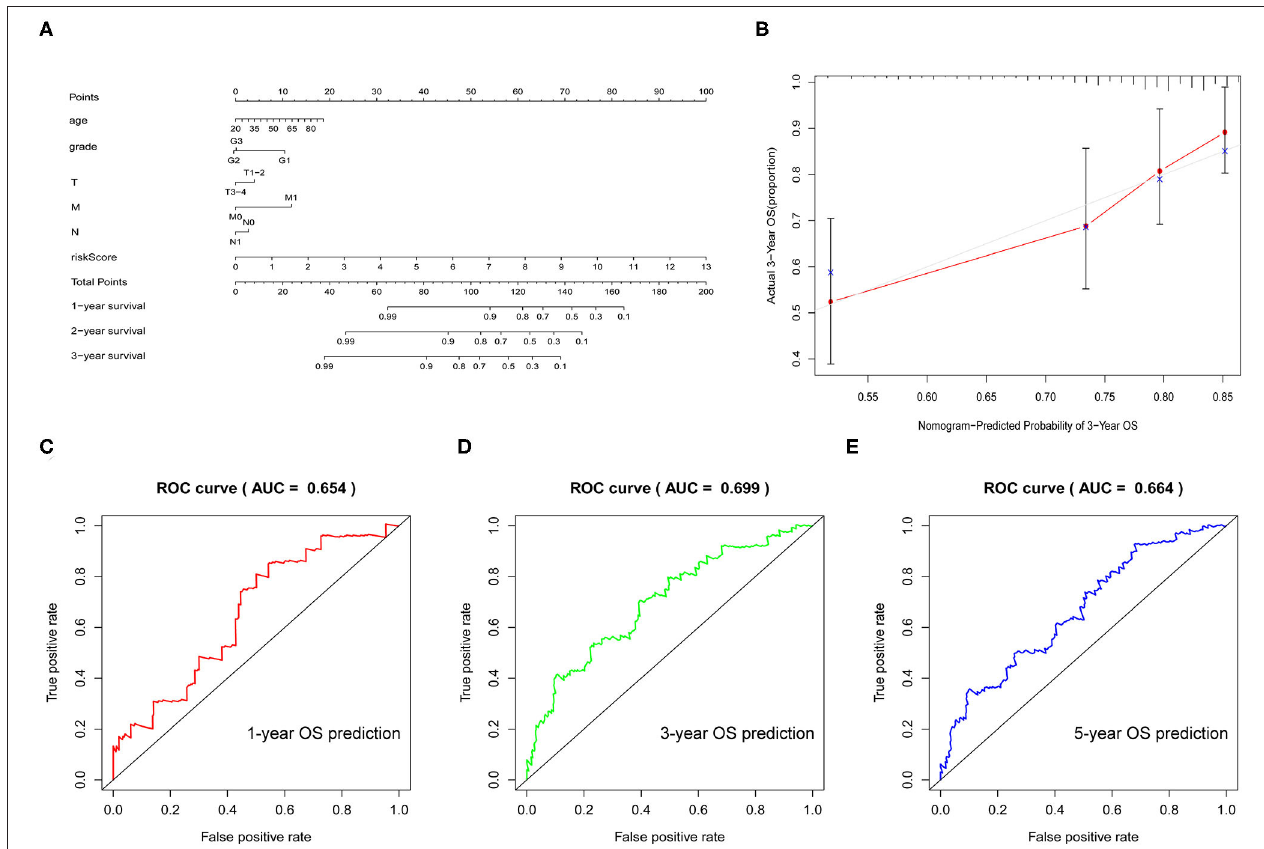
FIGURE 7 | Verification of the prognostic model. (A) Nomogram was used to predict the 1-, 3-, and 5-year survival rates of patients with CESC. (B) Nomogram-predicting 3-year overall survival (OS). (C–E) Receiver operating characteristic (ROC) curve used to analyze the accuracy of the prediction